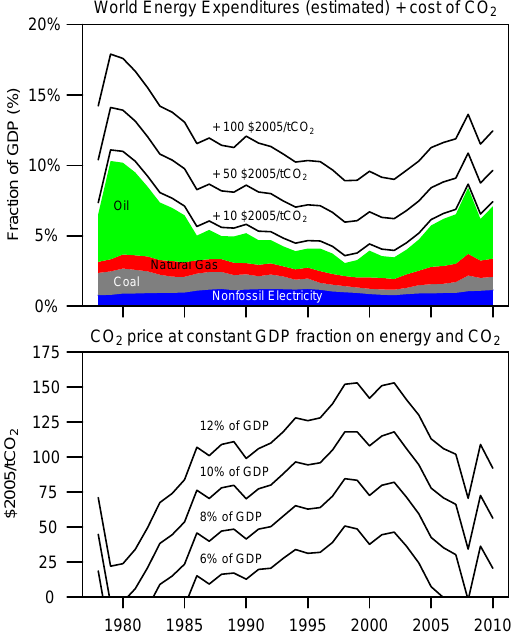
Figure 3. Top: Estimated expenditures on energy ( f e ,GDP ) as a fraction of GDP (for the 44 countries in the data set) from 1978 to 2010 including hypothetical costs on CO 2 emissions of 10, 50, and 100 $2005/tCO 2 . The data for annual CO 2 emissions from fossil energy (oil, natural gas, and coal) are from the IEA website [62] Bottom: The CO 2 cost that would cause expenditures for both energy and CO 2 combined to equal a constant fraction of GDP each